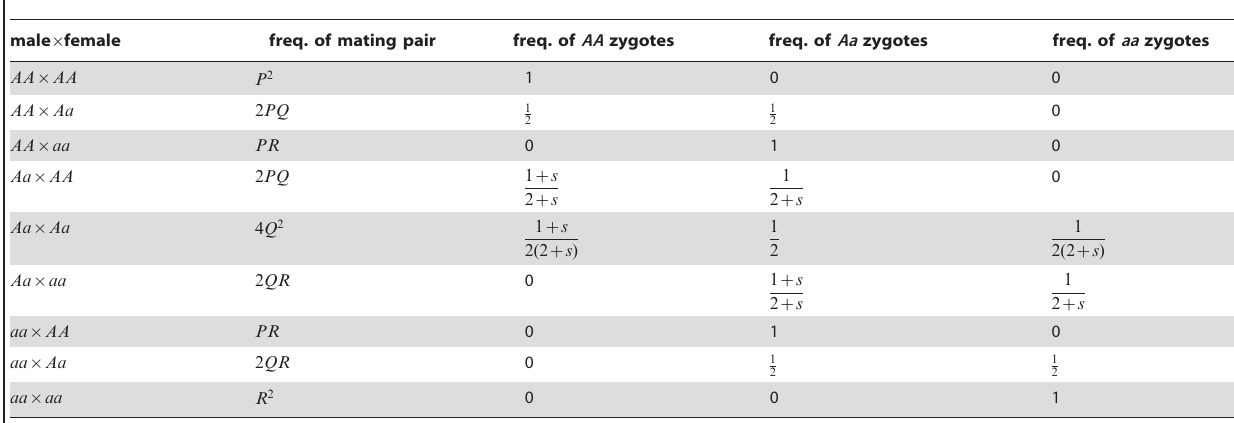
freq. of mating pair freq. of AA zygotes freq. of Aa zygotes freq. of aa